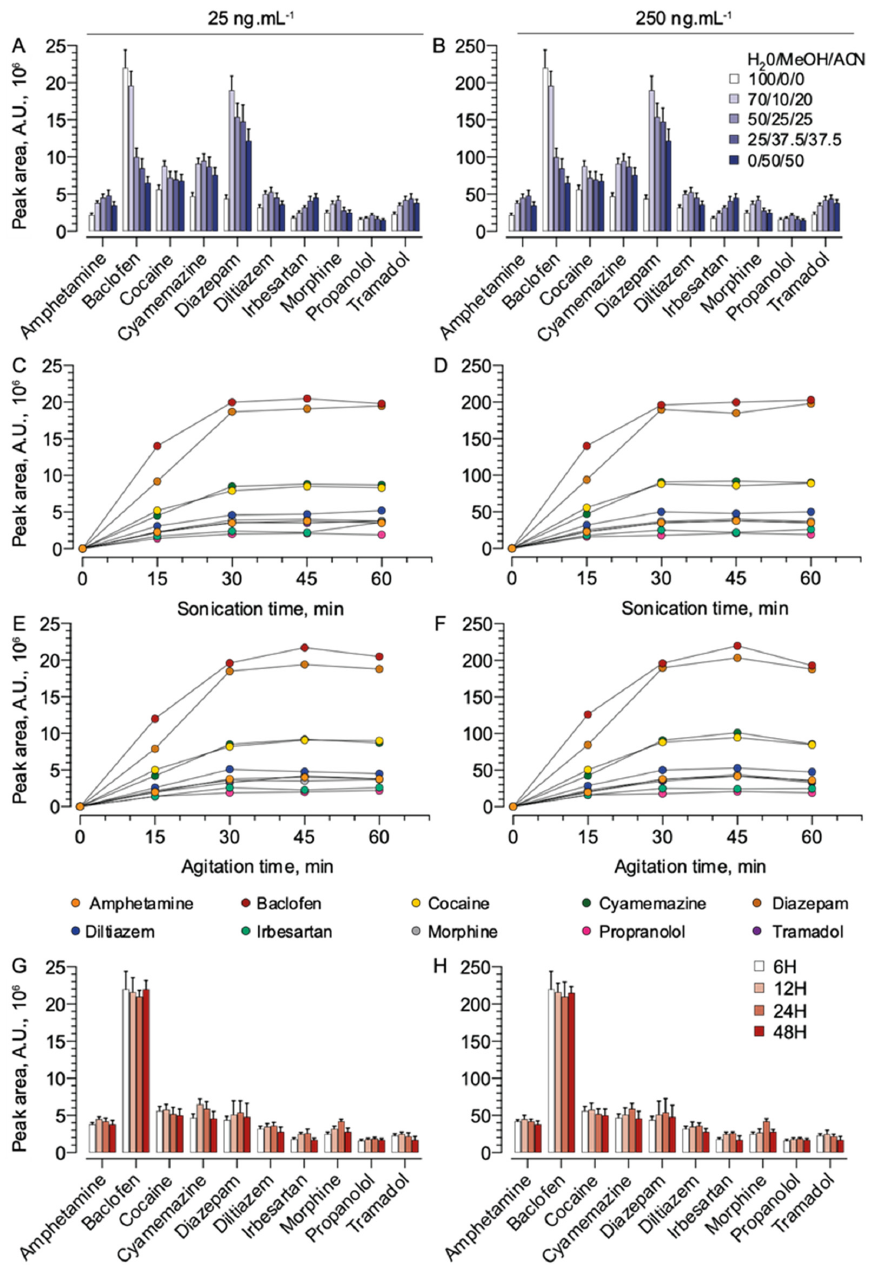
Figure 1. Effects of the extraction mixture’s composition ( A , B ), sonication duration ( C , D ), agitation duration ( E , F ), and the time elapsed between filling the Mitra TM devices and the extraction ( G , H ) on the response intensity of 10 selected molecules at 25 and 250 ng·mL − 1 . Results are expressed as the mean ± standard deviations of three independent replicates. A.U.: Arbitrary Unit.